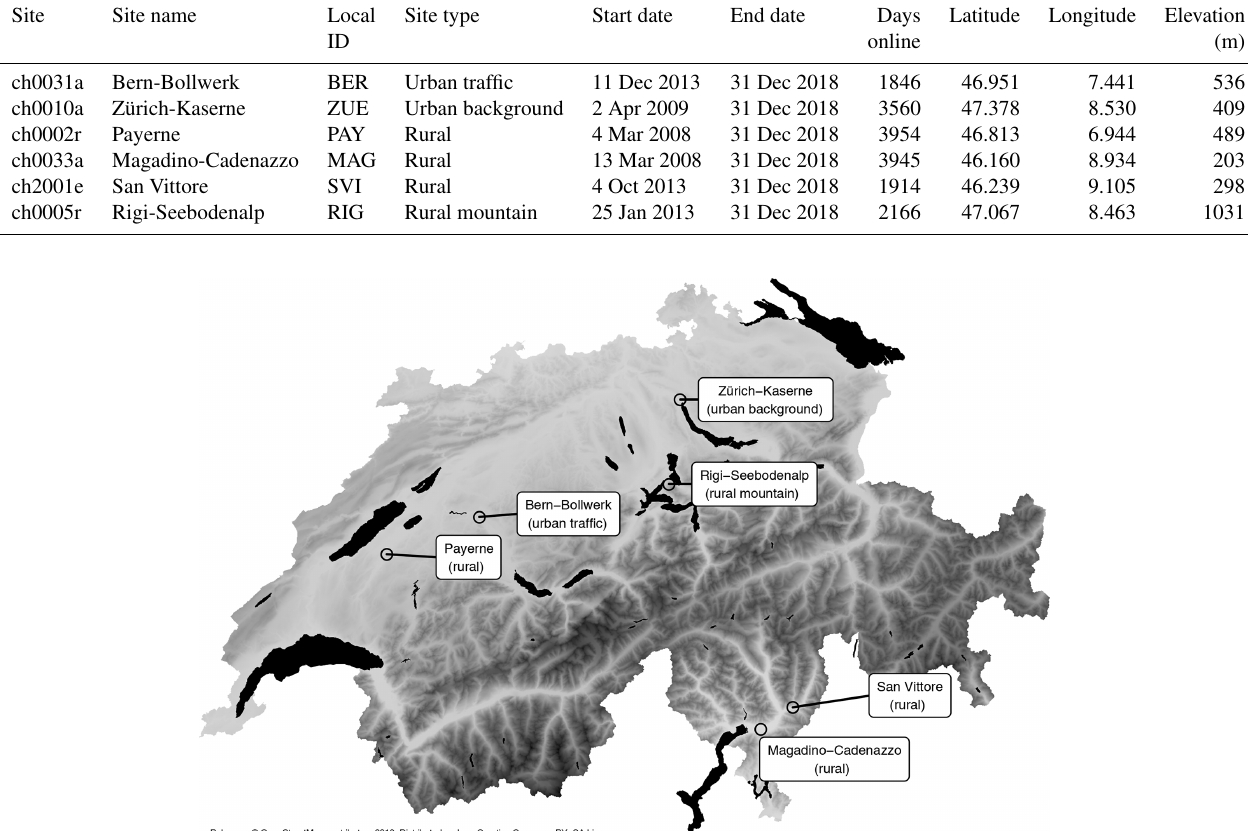
Figure 2. The six Swiss equivalent black carbon (EBC) monitoring sites used in the analysis and their site classifications. Solid black areas are significant water bodies, and shading represents the terrain and elevation. The boundaries of Switzerland and the lakes were extracted from © OpenStreetMap (OpenStreetMap contributors, 2019), and the heights were derived from Switzerland’s digital height model (Swiss Federal Office of Topography,